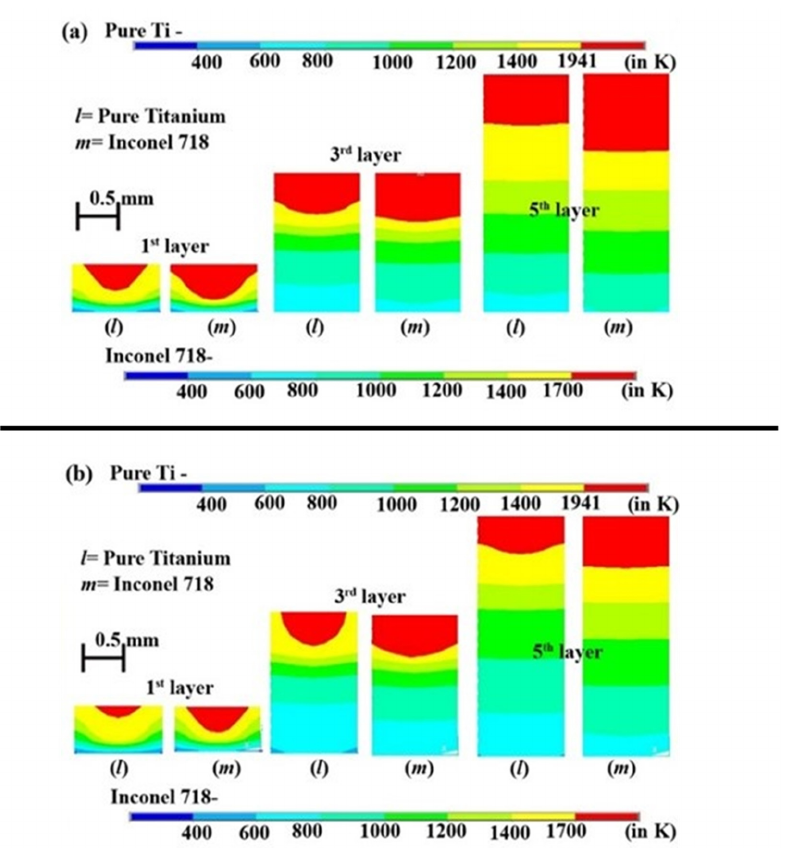
Figure 11. The difference of melt-pool dimensions for pure Ti and Inconel 718 alloy for the ( a ) da- taset#4 and ( b ) dataset#3.